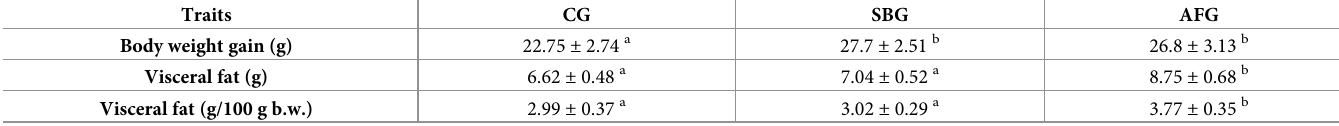
CG—Control Group, SBG—Sucrose Balanced Group, AFG—Alternately Fed Group a,b—Means marked with different letters in the same line are statistically different, p �